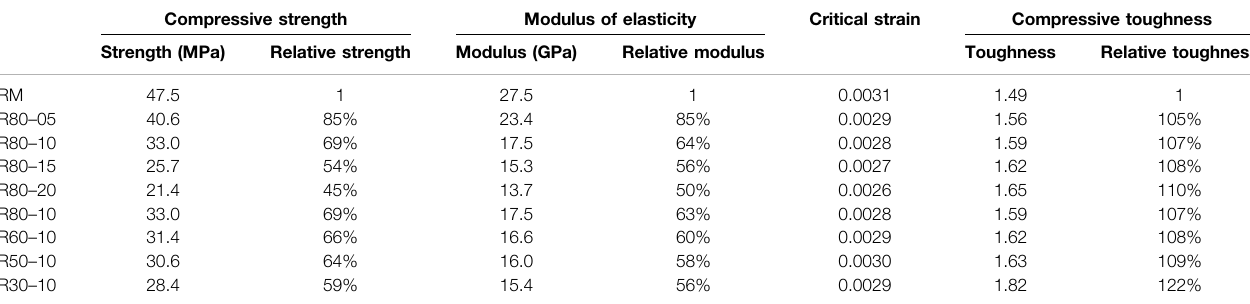
TABLE 3 | Static stress-strain test results for all groups.